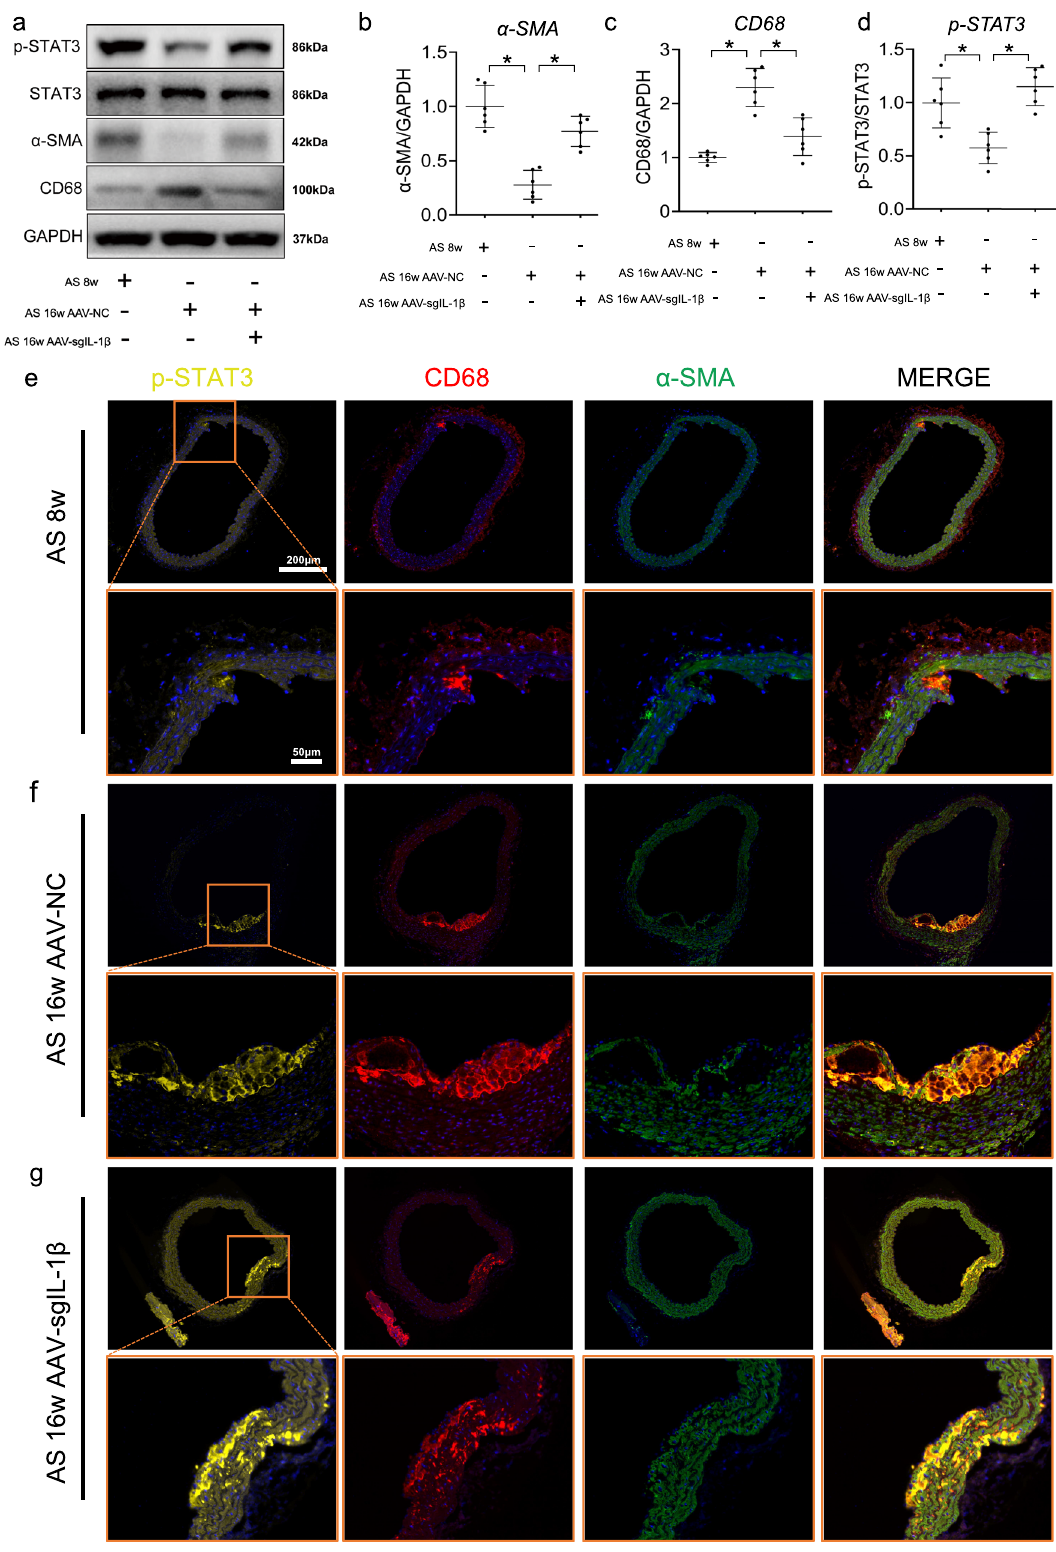
Fig. 8 In vivo experiments identify the inverse correlations of IL-1 β with STAT3 in aorta of mice. a Western blot assays illustrate the effect of adeno- associated virus-sgIL-1 β (AAV-sgIL-1 β ) on the expression of main SMC subsets transcription factors in vivo. Quanti fi cations of b p-STAT3, c vascular smooth muscle cell (VSMC) marker ( α -SMA), d macrophage marker (CD68) in aorta of mice from each group. Representative immuno fl uorescence staining of p-STAT3 (yellow) expressing plaque macrophage-like VSMCs in ApoE − / − mice at e 8 weeks, f 16 weeks, and treated with ( g ) AAV-sgIL-1 β fed HFD. Eighteen ApoE − / − mice were randomly grouped into three groups, including high-fat diet (HFD) treated 8 weeks ( n = 6), 16 weeks ( n = 6), and AAV-sgIL-1 β ( n = 6) mice. Data are presented as mean ± SE. Mann – Whitney test: * P < 0.05.